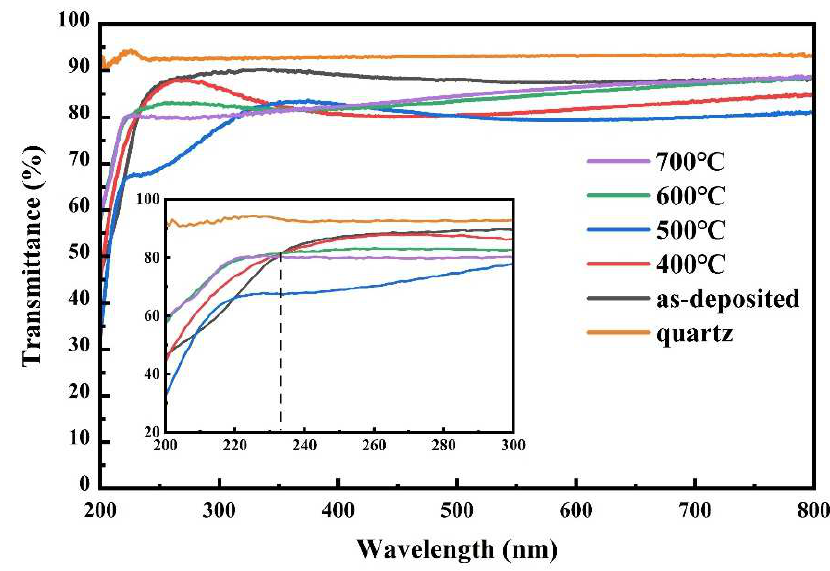
Figure 9. Transmission spectra of lanthanum-doped HfO 2 films at different temperatures.